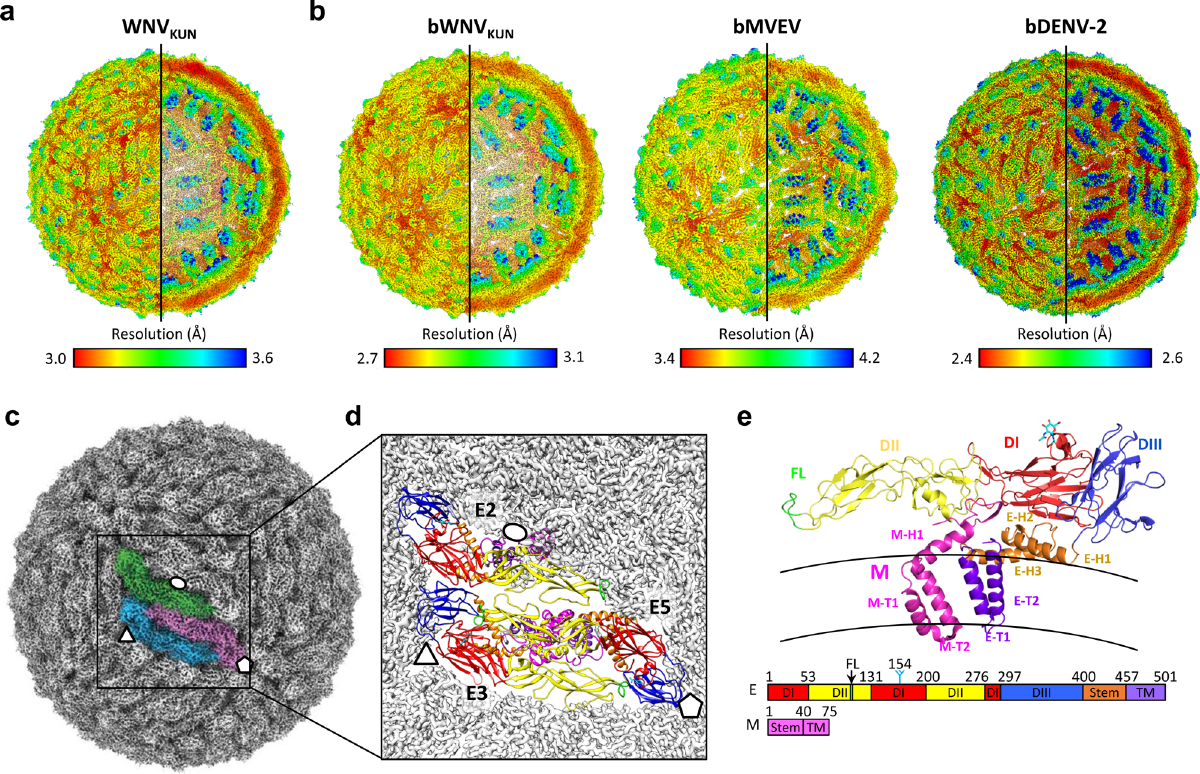
Fig. 2 A chimeric platform facilitates high-resolution structure determination of fl aviviruses particles. a , b Cryo-EM reconstructions of a WNV KUN and b the chimeric viruses bWNV KUN , bMVEV and bDENV-2 coloured by local resolution in a rainbow gradient from high (red) to low (blue). c The asymmetric unit of WNV KUN is composed of three copies of E (green, pink and blue) and M (not visible). Ellipses, triangles and pentagons represent the 2-, 3- and 5-fold icosahedral axes, respectively. d Asymmetric unit displayed as a cartoon and coloured by domain. Each E protein is labelled according to its proximity to the icosahedral symmetry axes. e A cartoon representation of the WNV KUN structure coloured by domain according to the domain diagram below: E ectodomain 1 (DI, red) containing an N-linked glycan at Asn154 (cyan); E ectodomain 2 (DII, yellow) containing a fusion loop (FL, green); E ectodomain 3 (DIII, blue); E membrane domain (purple) consisting of a stem of three membrane-proximal helices (E-H1, E-H2 and E-H3) and two transmembrane helices (E-T1 and E-T2); M membrane domain (magenta) consisting of a stem helix (M-H1) and two transmembrane helices (M-T1 and